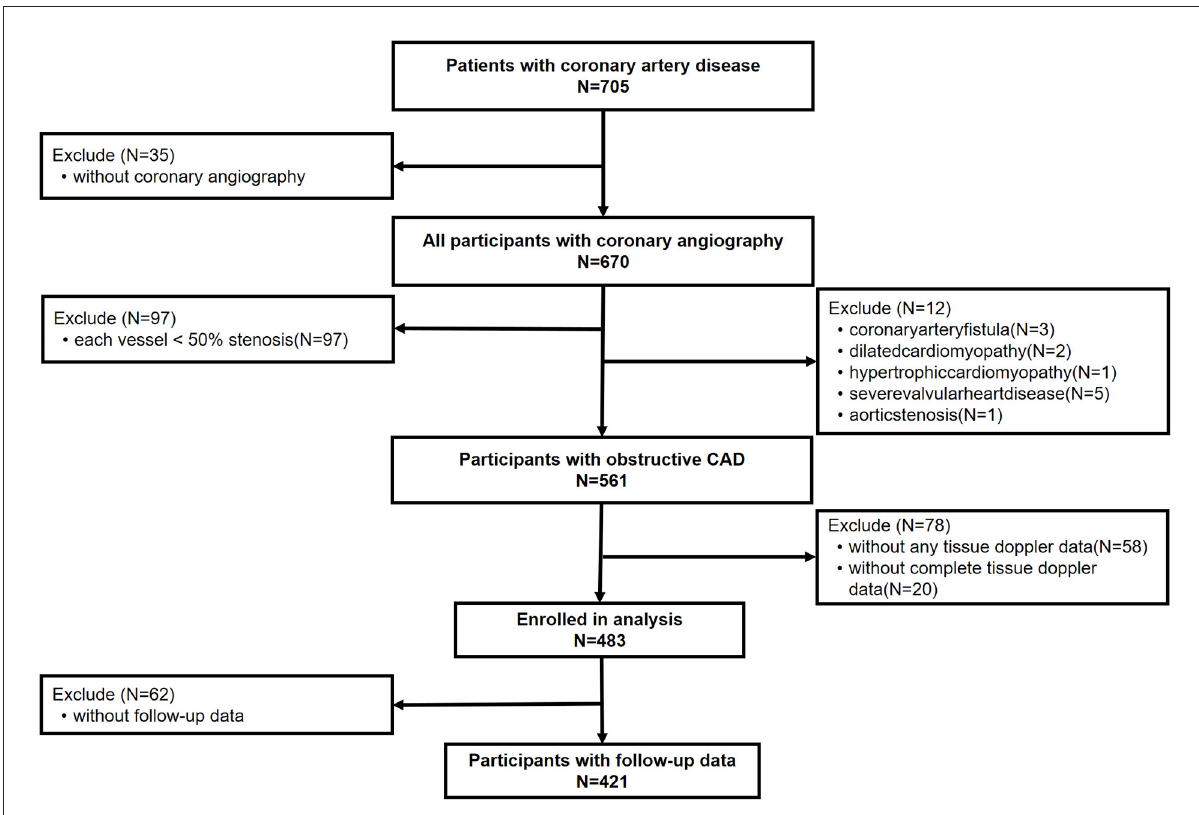
FIGURE1 Screening flow of patients included in research. Obstructive CAD is defined as with a ≥ 50% stenosis in at least one of the main coronary arteries, confirmed by coronary angiography or with a history of coronary artery bypass grafting or coronary stent implantation. CAD, coronary artery